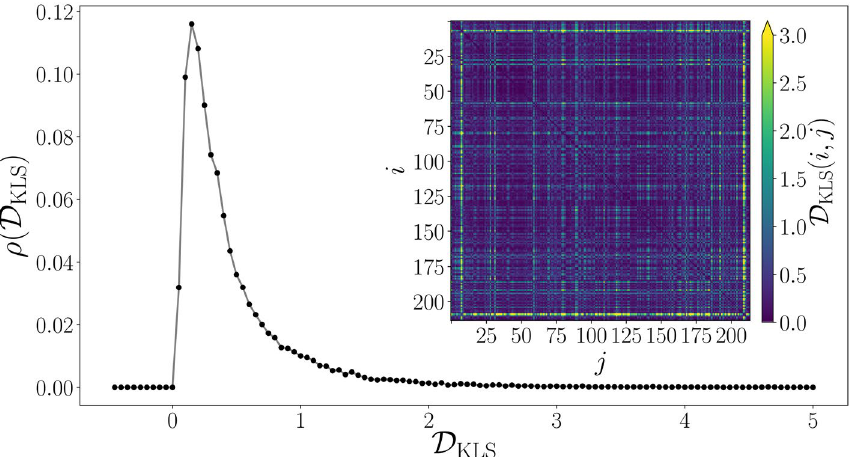
Figure 4. Statistical analysis of symmetric Kullback–Leibler distances between segments. The values D KLS are obtained from Eq. (2) for all the segment pairs i , j = 1, . . . , 214 . We present the probability density ρ( D KLS ) obtained with bin counts in intervals with (cid:31) D KLS = 0.05 , the inset shows the matrix representation with entries D KLS ( i , j ) codified in the color bar. All figures were created using python 3.8 and the matplotlib (3.4.3) package (https:// matpl otlib.